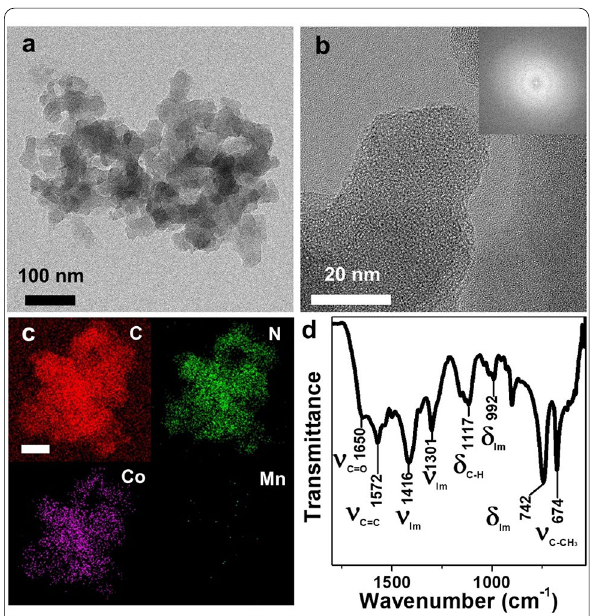
Fig. 1 Structure of MnCoNCF before annealing. a TEM, b HR‑TEM (inset: FFT‑pattern), and c Elemental mapping images of